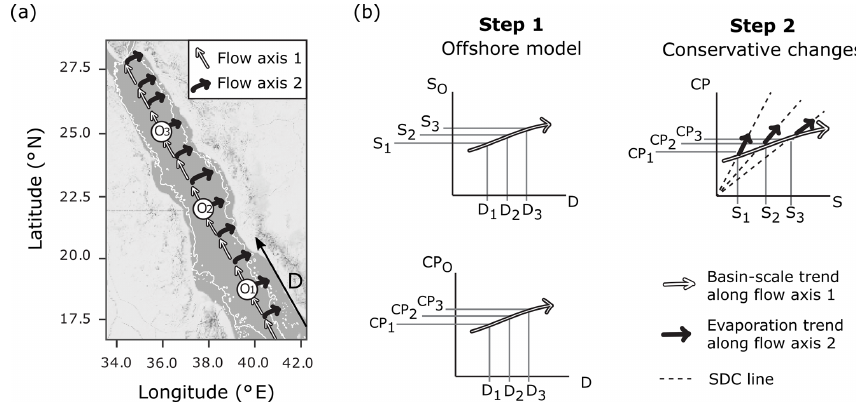
Figure 1. Schematic of the single-end-member mixing model used in the present study. Panel (a) displays the assumed circulation pattern which has two flow axes overlaid on a map of the Red Sea produced using ©Stamen Design LLC and R software. Flow axis 1 is along the south–north central axis where waters experience cumulative changes due to basin-scale evaporation and calcification. Flow axis 2 is perpendicular to this axis, where it is assumed that evaporative effects prevail as waters transition from offshore locations ( O i ) to coastal regions. The thin white line indicates the 200m bathymetry. Panel (b) explains the single-end-member mixing model in two steps, to de- termine conservative estimates of a carbonate parameter (CP:TA or DIC) for the coastal zone. O i represents an offshore end-member at a location in offshore waters lying along flow axis 1 (the central axis) at distance D i , from a fixed reference point in the southern Red Sea, and corresponding salinity S i and carbonate parameter measurement CP i , as derived from basin-scale linear relationships. CP i is then scaled along the simple dilution and concentration (SDC) line to obtain coastal estimates for carbonate parameters.